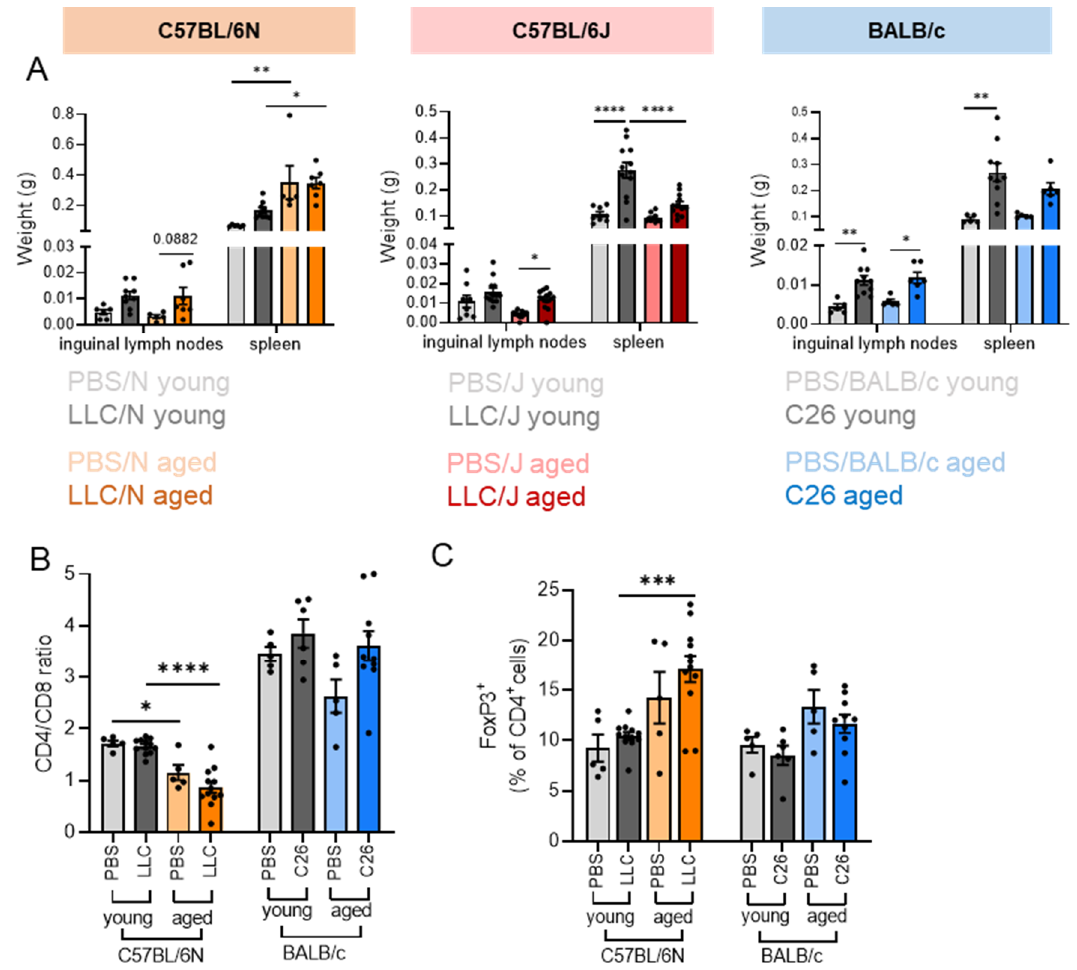
Figure 3. Cachexia development in aged mice is not associated with alterations in immune cell subtype composition. ( A – C ) Same mice as in Figure 2 were used for the analysis of immunologic changes upon aging. ( A ) Tissue weights of inguinal lymph nodes and spleen. ( B ) CD4/CD8 ratio of T cells isolated from blood. ( C ) Percentage of FoxP3-positive cells (% of CD4 + T cells). T cells isolated from blood. Data are mean ± s.e.m. Statistical analyses were performed using two-way ANOVA with Tukey’s multiple-comparison post hoc test. * p < 0.05, ** p < 0.01, *** p < 0.001, **** p < 0.0001.